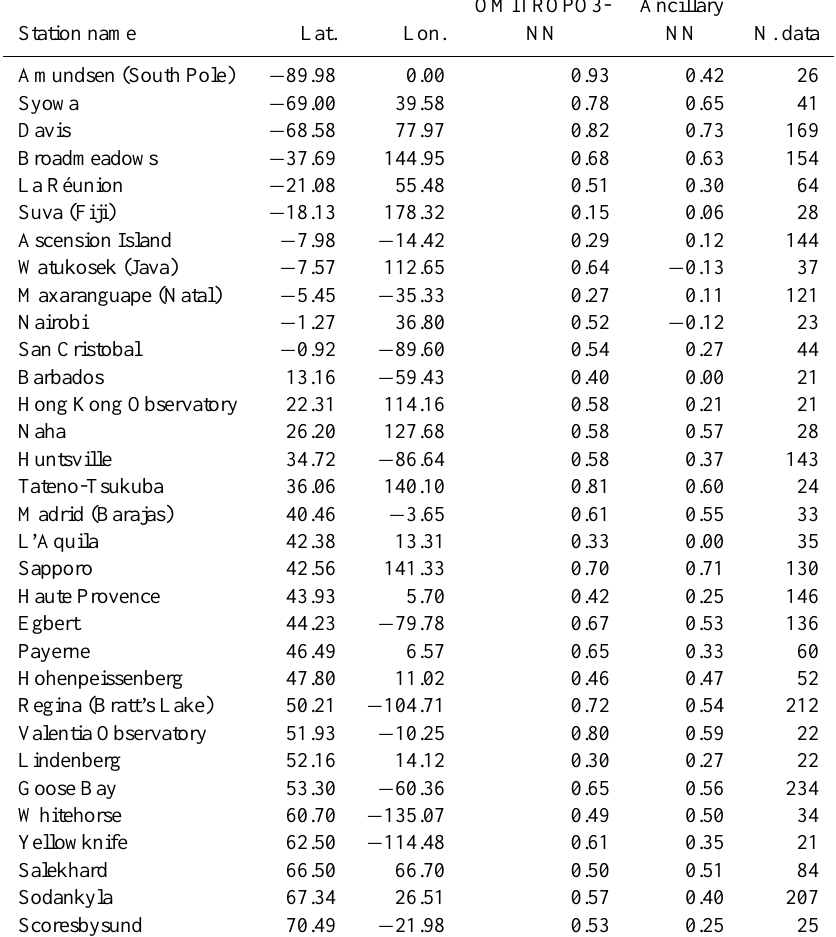
Table 6. Pearson correlation coefficients between observed and estimated TCO anomalies for the OMITROPO3-NN and for the NN trained without OMI reflectances, divided by station, sorted by increasing latitude. Only stations with at least 20 measurements included in the D test set were